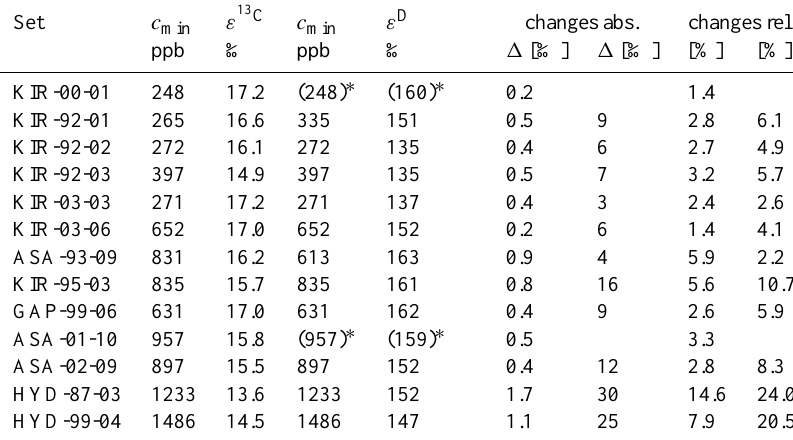
Table 5. Mean fractionation constants ε 13 C and ε D , corrected for tropospheric trends. The absolute differences in ‰ and the relative change in % to the uncorrected fractionation constants are stated in the right